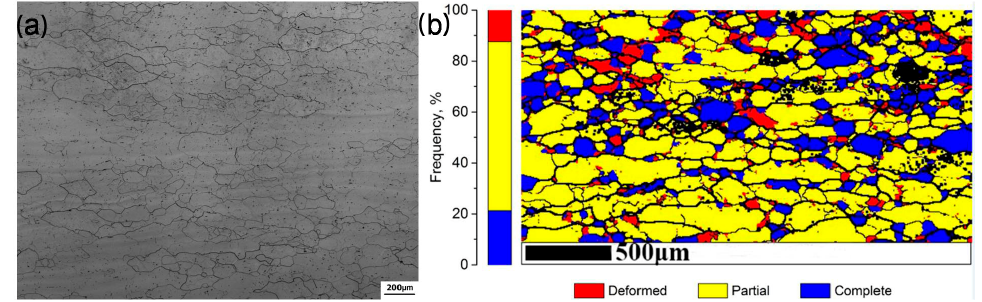
Figure 14. ( a ) microstructure; ( b ) recrystallized fractions of Domain 5 at the true strain of 0.7.